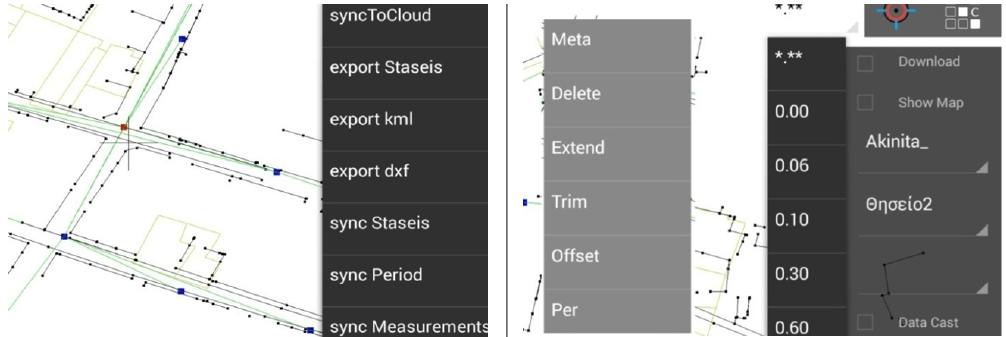
Figure 7: Portable client vector